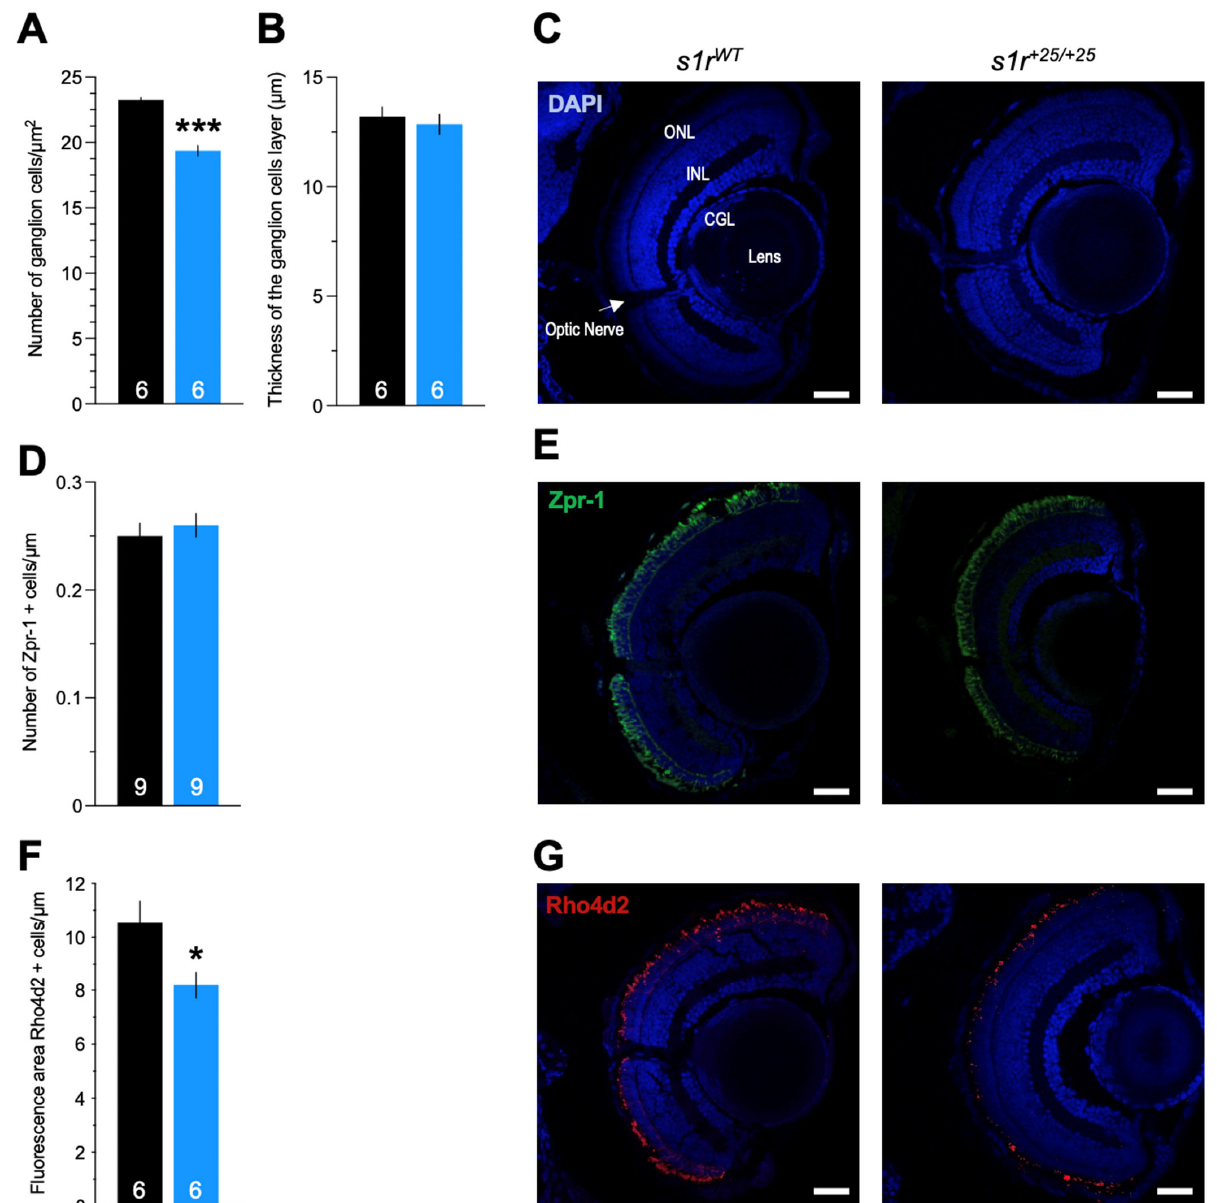
Figure 3. Morphological analysis of the neurons in the zebrafish retina. ( A ) Quantification of the number of ganglion cells, ( B ) quantification of the thickness of the associated layer, and ( C ) typical micrographs of the retina. Confocal images were obtained from section from s1r WT and s1r +25/+25 zebrafish retina, showing cell nuclei labeled with 4 (cid:48) ,6-diamidino-2- phenylindole (DAPI, blue). ( D ) Quantification of photoreceptor cells (red and green cones) labelled with Zpr-1 antibody and ( E ) typical micrographs of the cones (green). ( F ) Quantification of rods labelled with Rho4d2 antibody and ( G ) typical micrographs of the rods (red). Abbreviations: GCL, ganglion cell layer; INL, inner nuclear layer; ONL, outer nuclear layer. Scale bars in ( C , E , G ) = 30 µ m. The number of animals is indicated in the columns. * p < 0.05, *** p < 0.001; unpaired t